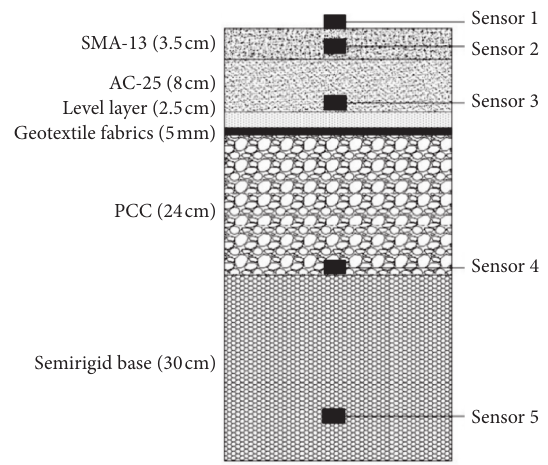
Figure 1: Pavement structure and layout of temperature sensors. Table 1: Depths of temperature sensors in pavement.